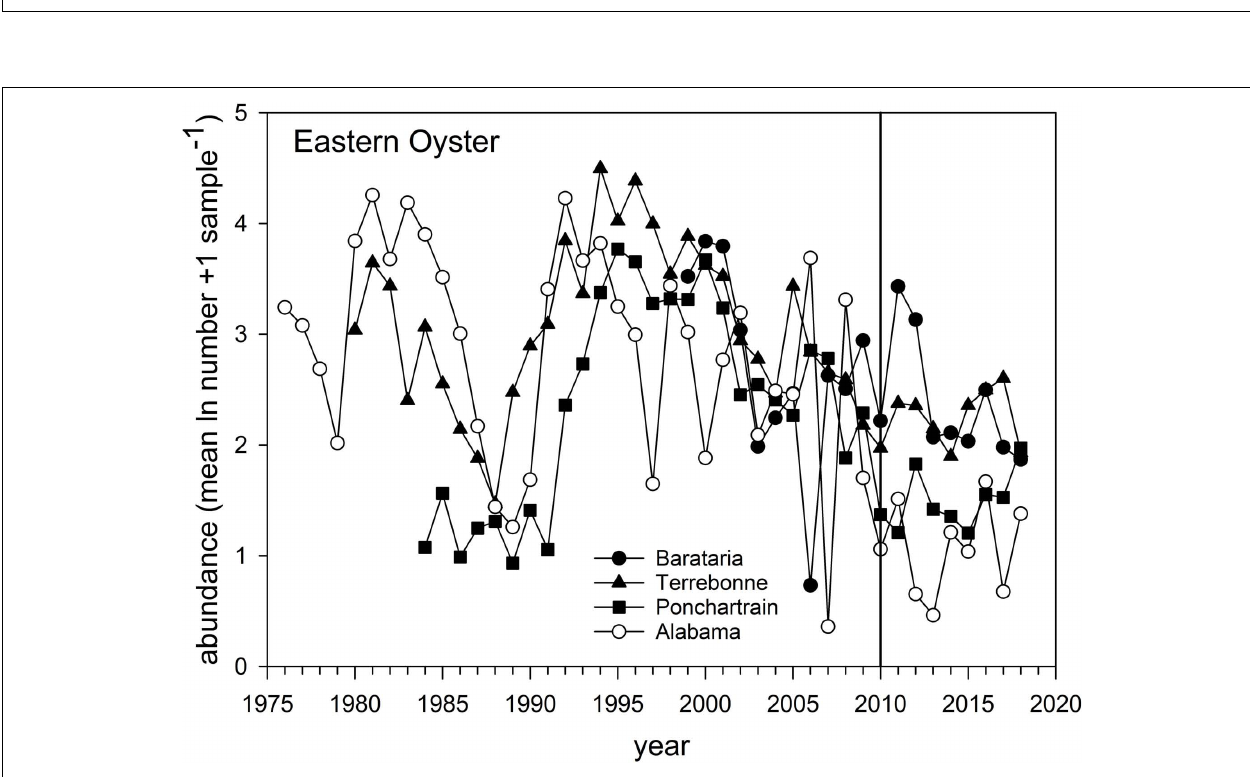
FIGURE 9 | Relative abundance of Eastern Oyster sampled in three Louisiana basins, 1980–2020, and off Alabama from 1976 to 2018. Data are the mean (ln + 1) abundance (numbers) caught in standardized sampling quadrats. Data are from the Alabama Marine Resources Department and the Louisiana Department of Wildlife and Fisheries oyster sampling quadrat